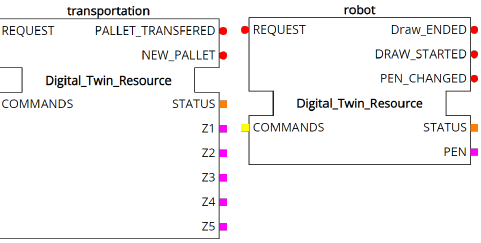
Figure 15. Two main production resources of the FASTory use case as digital twin resources. [Source: Own figure which is a snapshot from locally developed FB